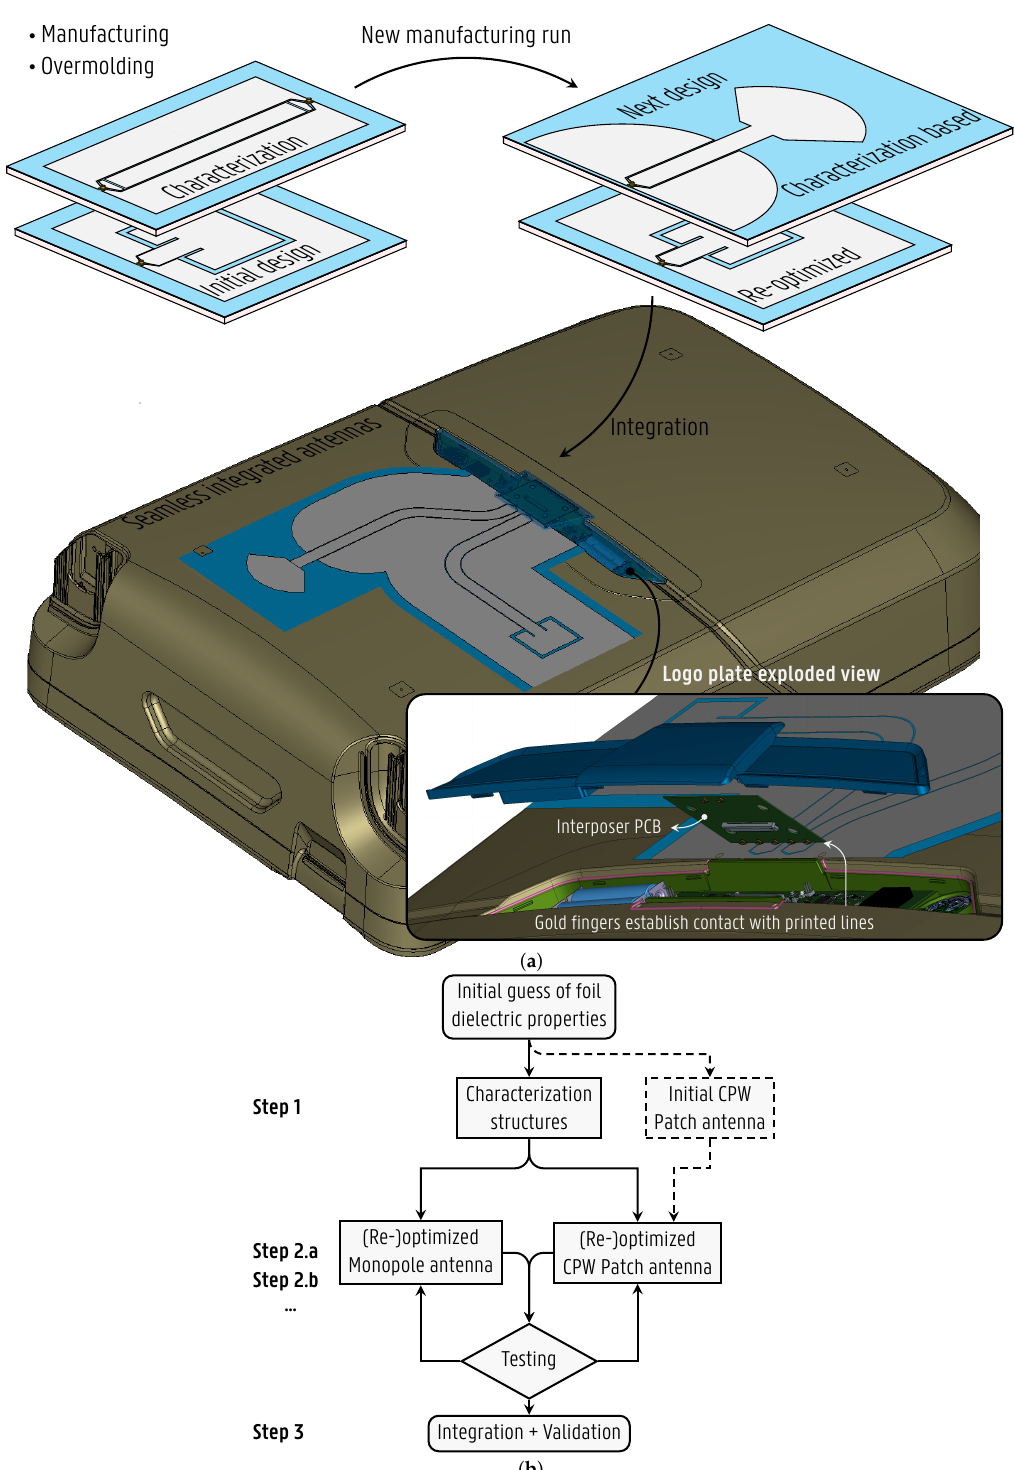
Figure 1. Design-for-integration process a as key enabler for a coplanar waveguide (CPW) patch and a CPW monopole antenna, covering the [2.4–2.5]GHz WiFi band and [862–928]MHz Sigfox band, respectively, seamlessly integrated into a suitcase shell. ( a ) Overview. The antennas are printed on a thermoplastic foil that is overmolded into the suitcase shell at high pressure at its casting resulting in seamless integration (see Figure 2). Inset: exploded view of suitcase’s logo plate, housing the radio frequency (RF) modules and the dedicated interposer printed circuit board (PCB), which interconnects the printed antennas. ( b )